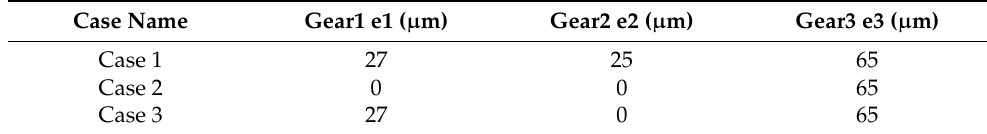
Table 4. Error values for analyzed three cases.